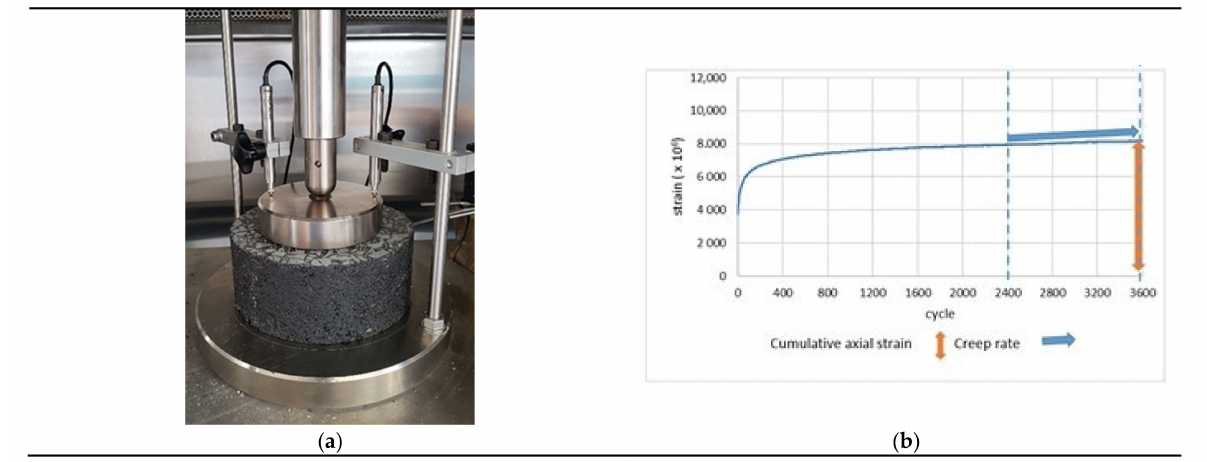
Figure 2. ( a ) The test apparatus of the cyclic uniaxial compression method; ( b ) the test result graph of the uniaxial cyclic compression method as applied to one